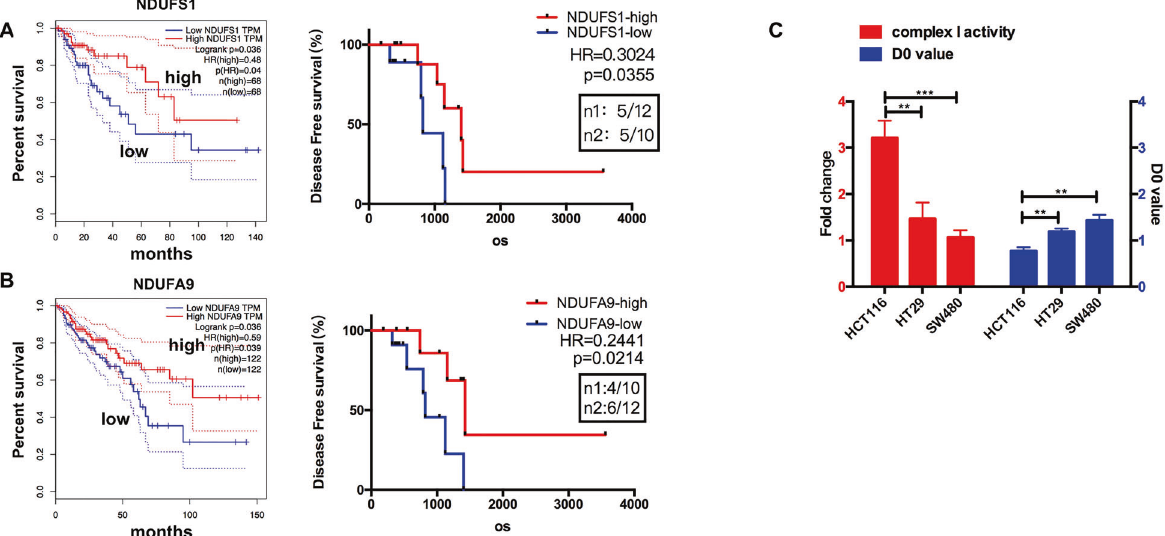
Fig. 1 Complex I components were downregulated in radioresistant cells and tumor tissues. A – B Kaplan – Meier curves showing the overall survivals and disease-free survivals in colorectal tumor cases with low or high NDUFS1 and NDUFA9. C Mitochondrial complex I activity in HCT116, HT29, and SW480 cells were shown in the left, and the D0 value of them were shown in the right. Data are presented as the means ± s.e.m. ( n = 3), ** P < 0.01, ***P <